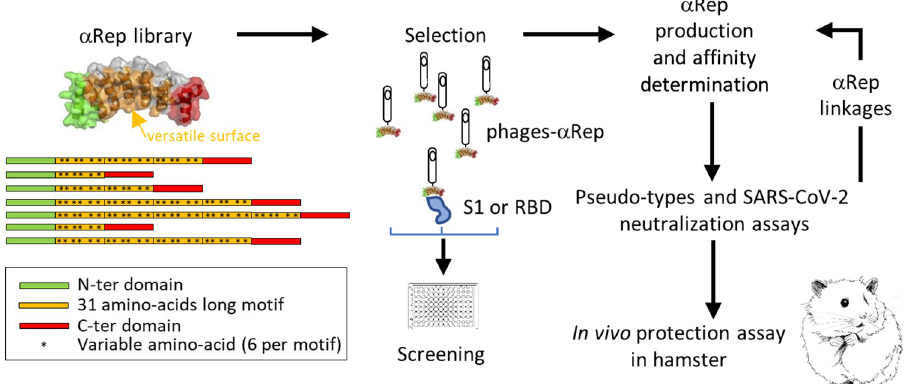
Fig 1. Selection and characterization of anti-spike α Reps. Screening an α Reps phage library allowed the identification of several binders specific of the RBD of the SARS-CoV-2 spike protein. Their binding affinity for the S1 domain was measured by biolayer interferometry. The neutralization activity of selected α Reps was evaluated using a pseudo-typed S SARS-CoV-2 neutralization assay and a SARS-CoV-2 infection assay. Competitive binding assays were carried out by BLI to identify α Reps recognizing non-overlapping binding sites. Then, α Rep derived constructs followed the same characterization steps than their single counterparts. The protective potency of the best candidate was analyzed in vivo in the golden Syrian hamster